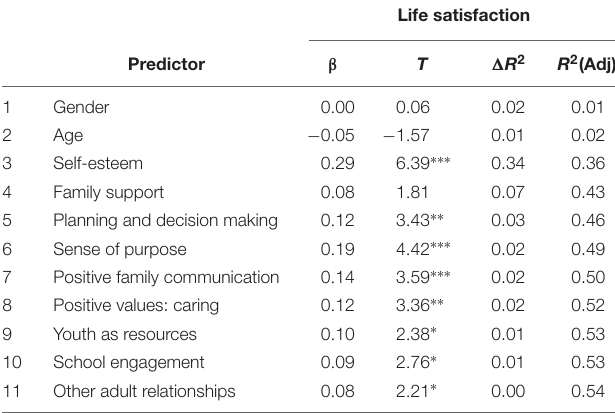
TABLE 5 | Predictors of life satisfaction (stepwise regression